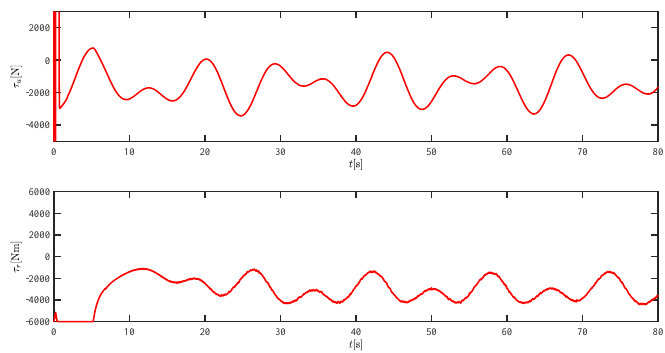
Figure 9. The force τ u and moment τ r at moderate